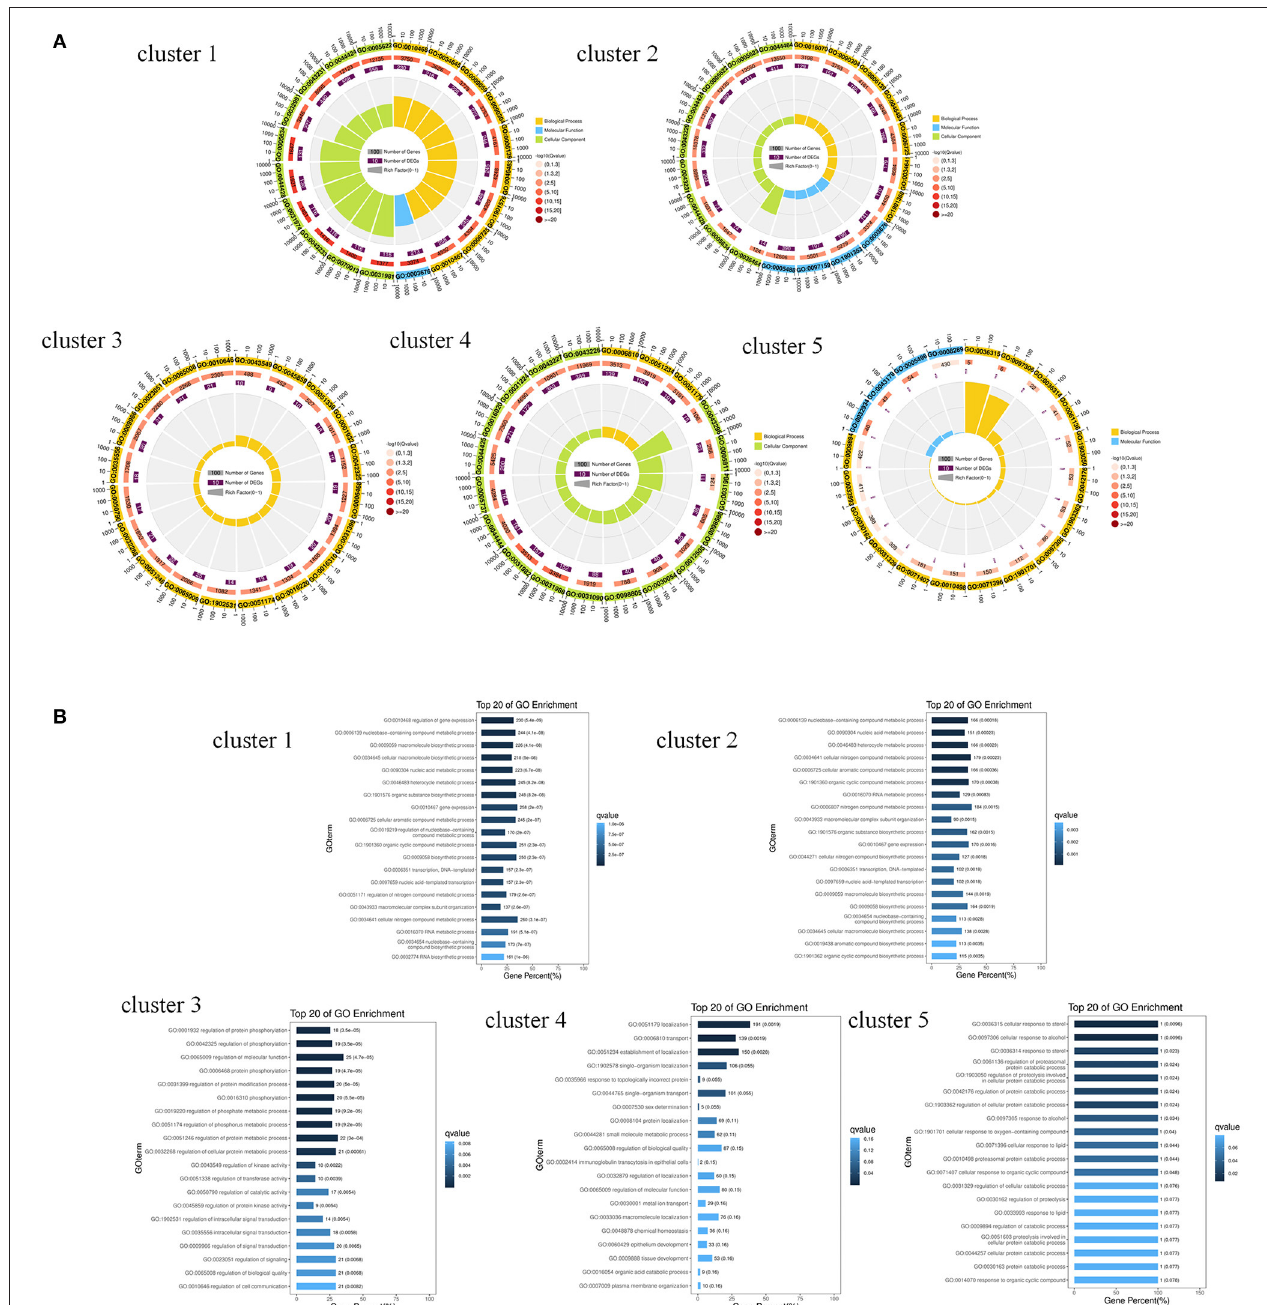
FIGURE 3 | GO enrichment analysis of miRNA predicted target genes. (A) The GO enrichment analysis of target genes predicted by miRNAs with different expression patterns. (B) The biological process terms of GO enrichment analysis of target genes predicted by miRNAs with different expression patterns. YWHAB , were predicted to be core genes. KEGG